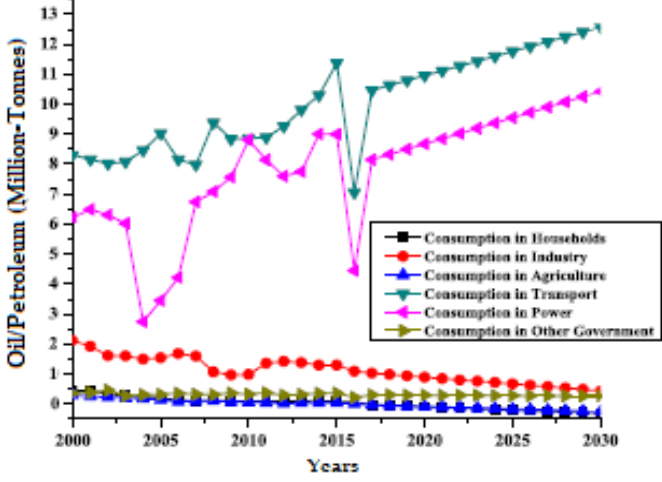
Figure 1. Transport-related energy consumption prediction [8].